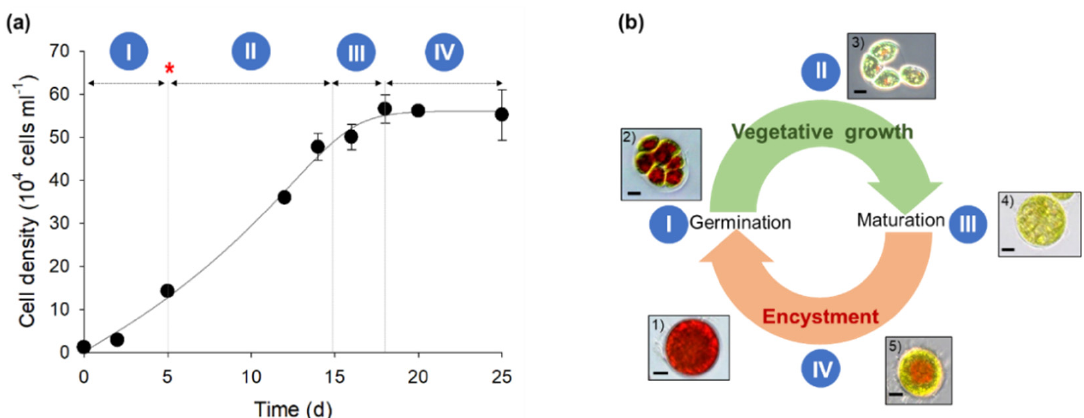
Figure 2. Time course profile of changes in the cell number density ( a ) and morphology ( b ) of Haematococcus pluvialis cells during photobioreactor cultivation for 25 days. The life cycle of H. pluvialis is characterized by five types of distinguishable cellular morphologies based on microscopic observation: (1) astaxanthin-rich asexual aplanospore; (2) dividing aplanospore with internal differentiated zooids; (3) green vegetative biflagellate cell; (4) green vegetative non-motile palmella; and (5) astaxanthin-accumulating palmella cell. The asterisk (*) indicates the growth stage of H. pluvialis cells used for the electric stimulation experiment. Scale bars in the optical images represent 10 μ m.